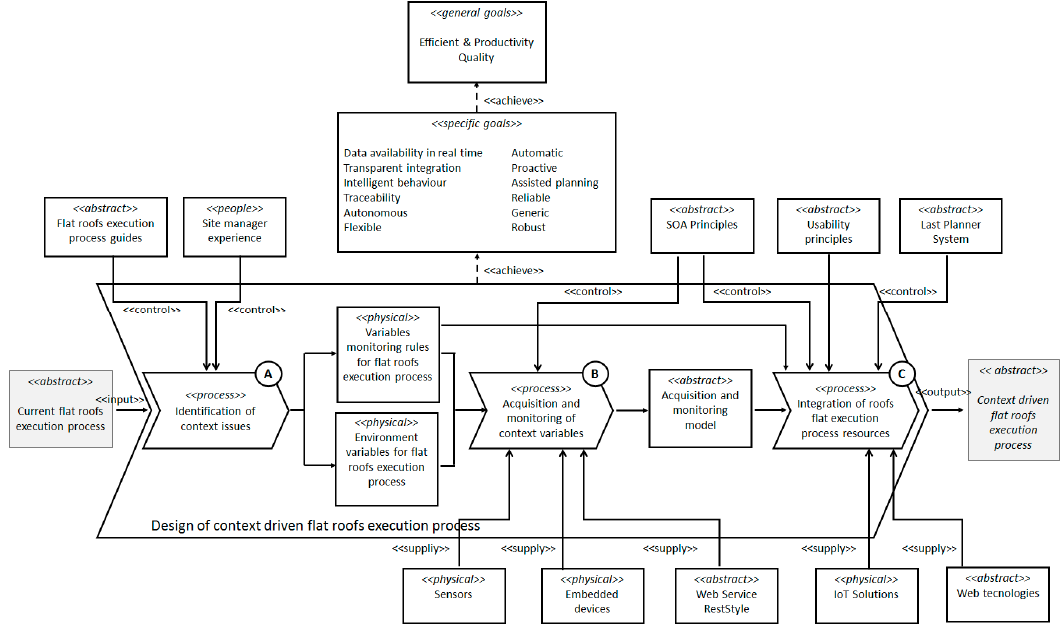
Figure 2. Modelling of the sub processes for achieving automated construction system through Eriksson-Penker notation.